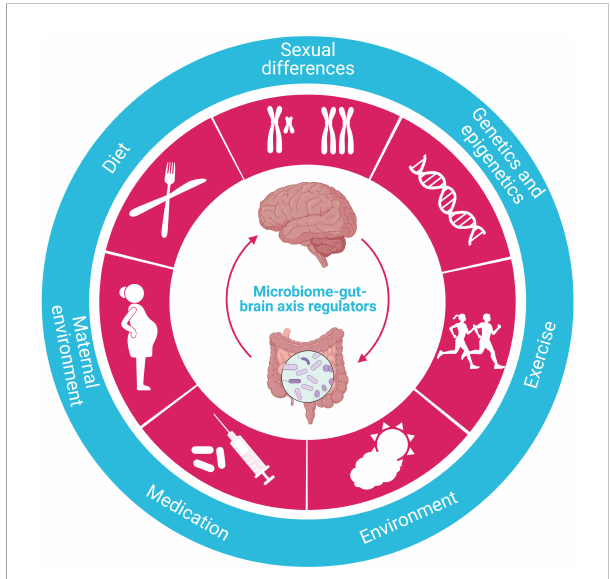
FIGURE 6 Regulators of the microbiome-gut-brain axis. The crucial function of the microbiome-gut-brain axis is regulated by various factors, such as diet, sexual differences, genetics/epigenetics, exercise, environment, medication, and maternal